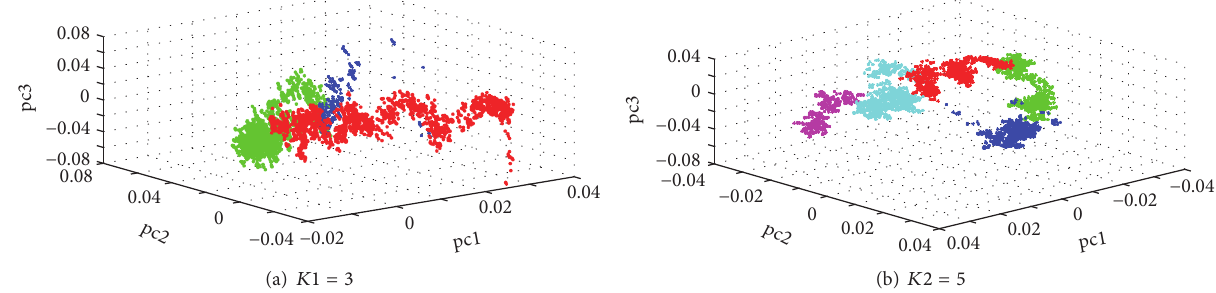
Figure 4: Principal components clustering distribution where 𝐾1 = 3 and 𝐾2 = 5 (pc: principal component).